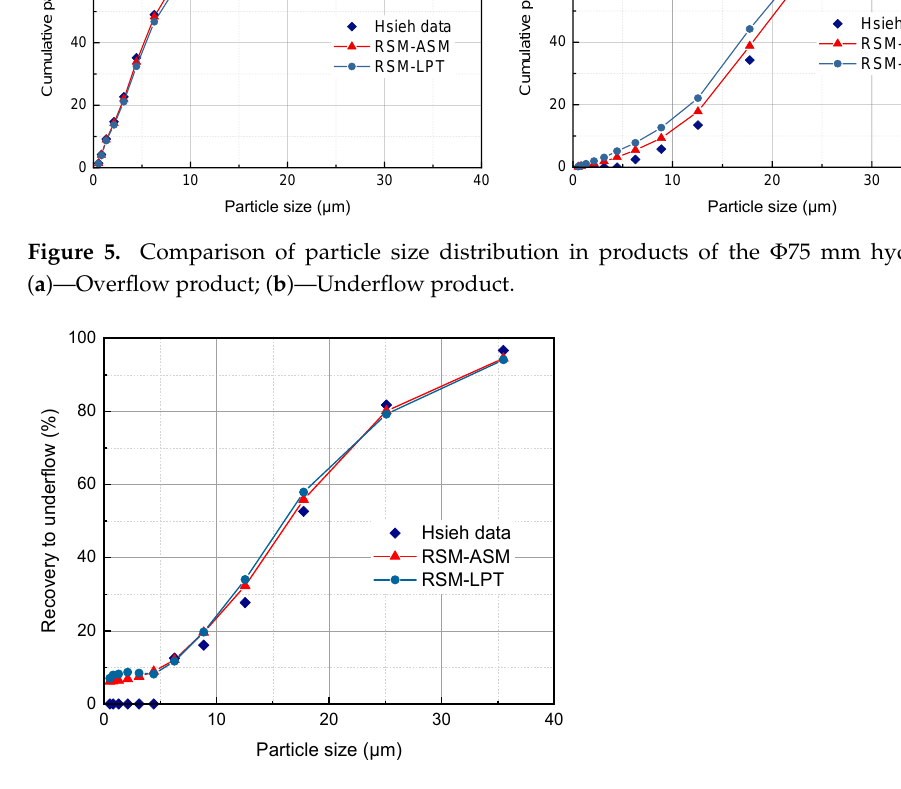
Figure 6. Comparison of partition curves of the Φ 75 mm hydrocyclone.